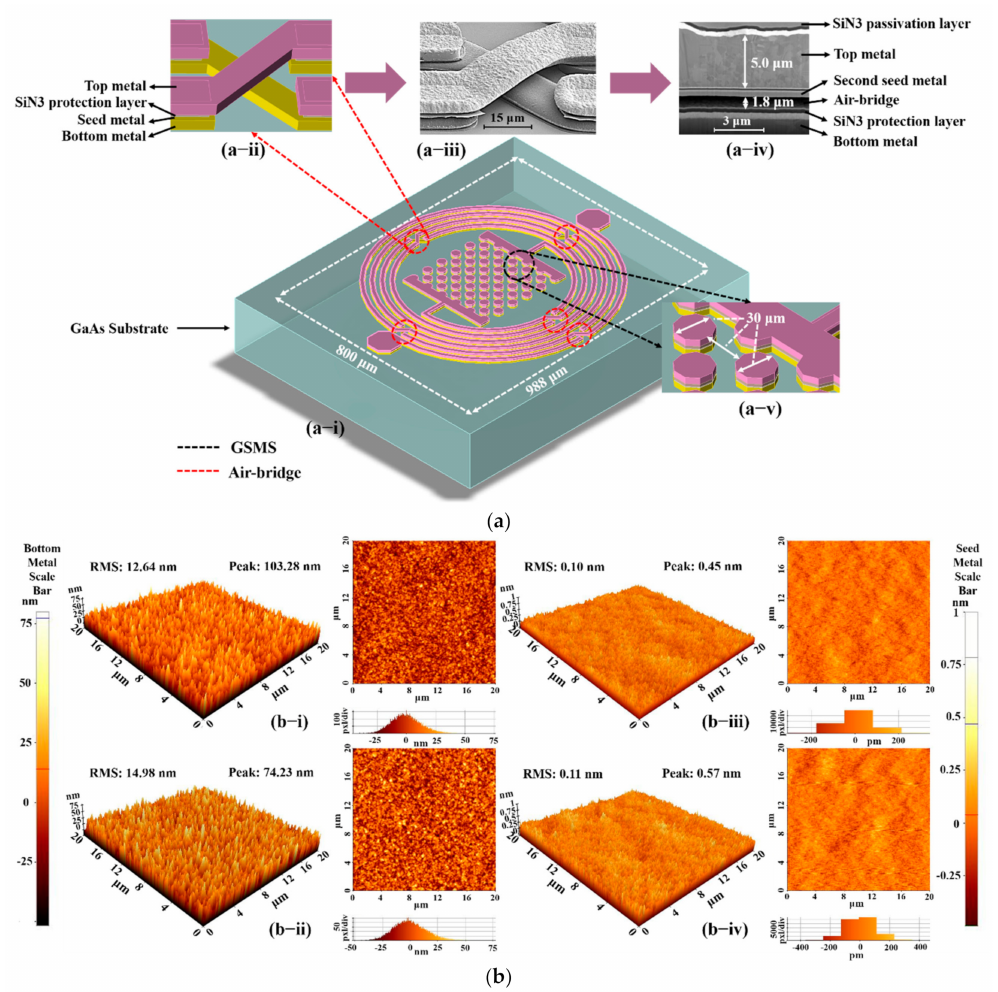
Figure 1. ( a ) Detailed information of proposed BPF: ( a-i ) 3D structure of the proposed BPF, ( a-ii ) magnified view of air bridge, ( a-iii ) SEM image of air bridge section, ( a-iv ) FIB image of air bridge section, ( a-v ) enlarged view of GSMS. ( b ) AFM images of fabricated BPF: ( b-i ) original bottom metal without Ar sputter etching process, ( b-ii ) current bottom metal with Ar sputter etching process, ( b-iii ) original seed metal without Ar sputter etching process, ( b-iv ) current seed metal with Ar sputter etching